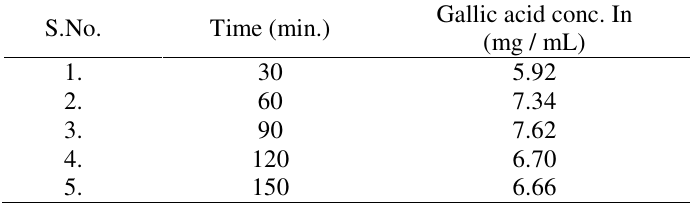
Table. 2. Production of gallic acid at optimal